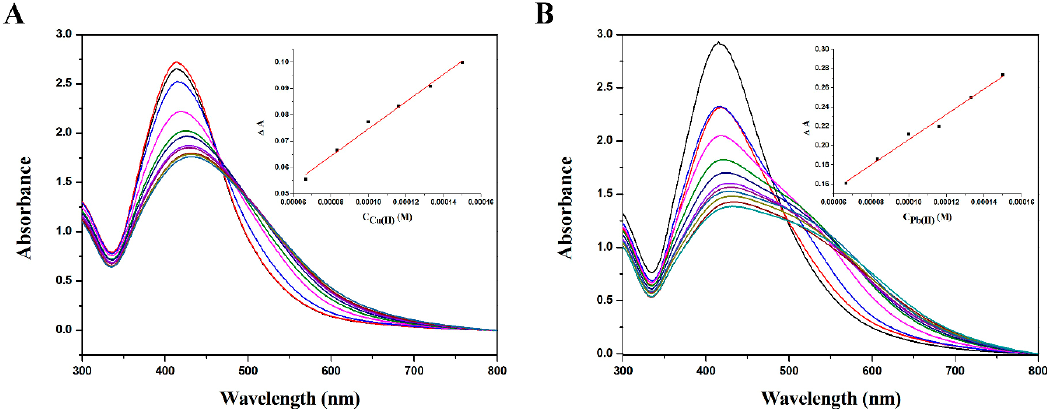
Figure 4. Surface plasmon resonance absorption changes of polyDOPA-AgNPs in the presence of different concentrations of ( A ) Cu 2+ and ( B ) Pb 2+ .